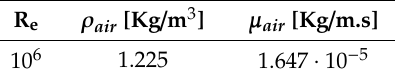
Table 4. Physical properties of air.